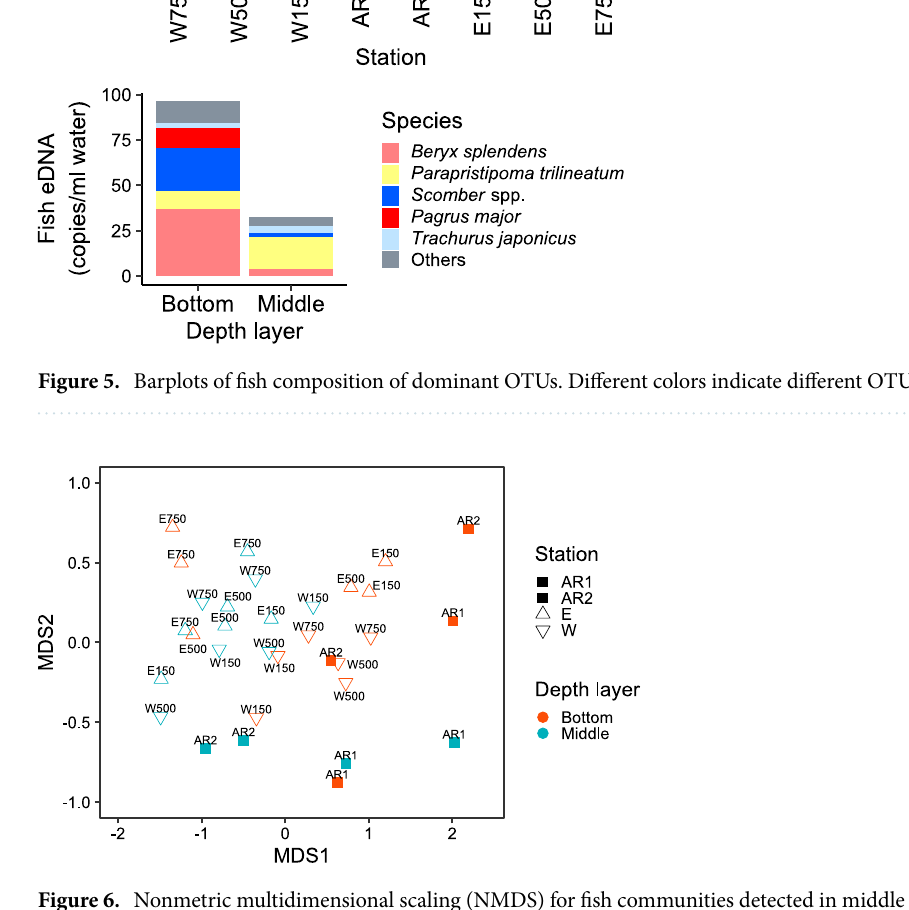
Figure 6. Nonmetric multidimensional scaling (NMDS) for fish communities detected in middle and bottom layers at sampling stations. NMDS stress was